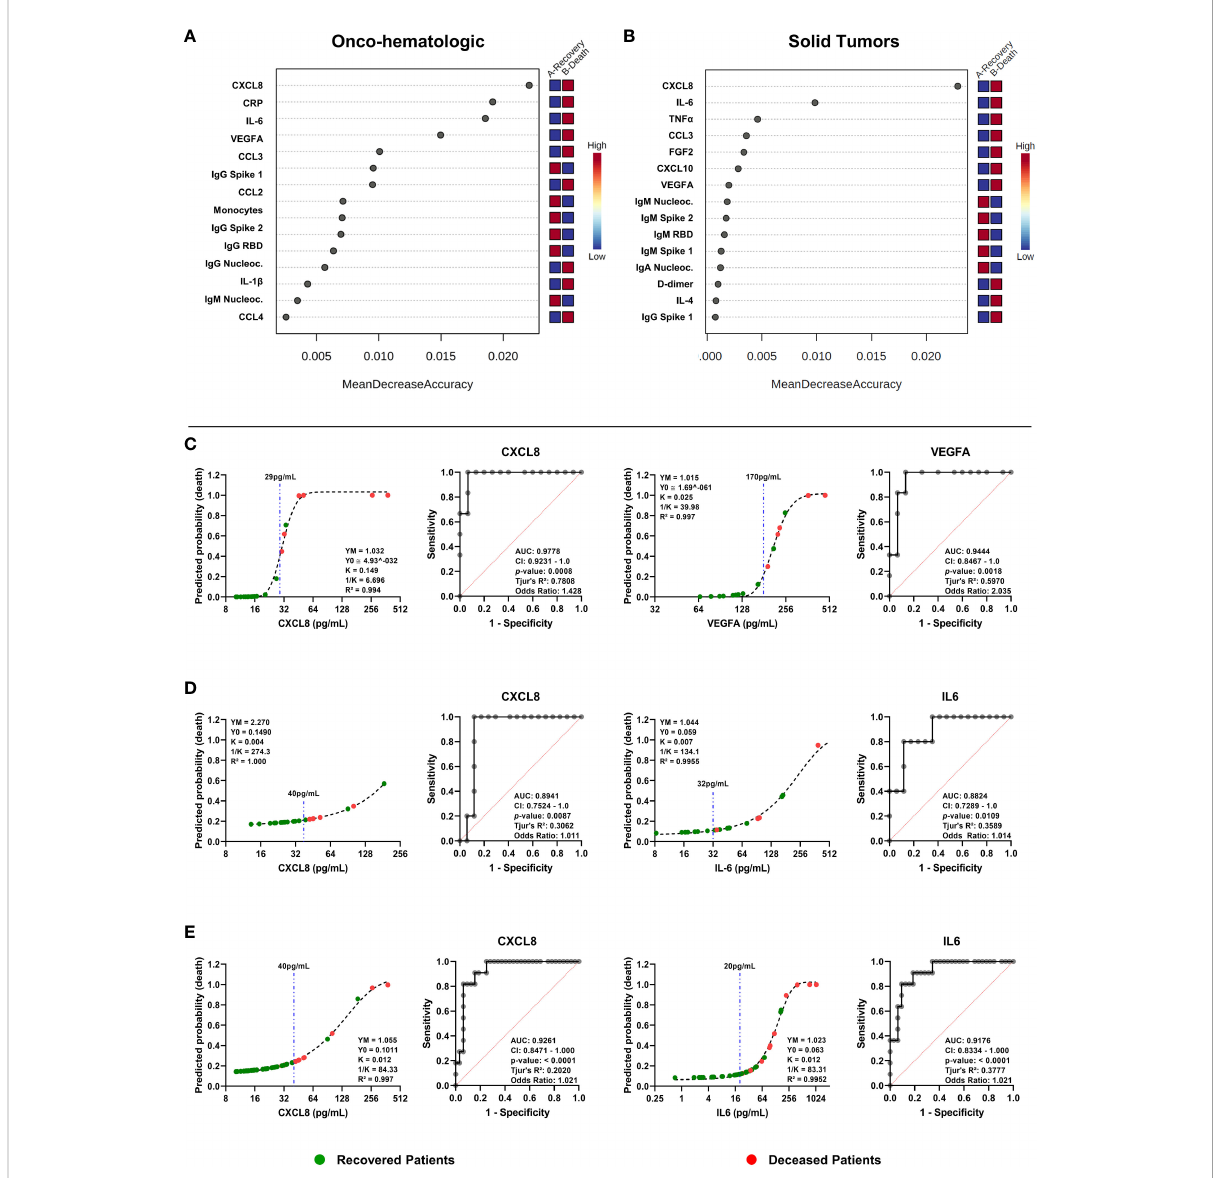
FIGURE 8 Random forests classi fi cation and receiver operating characteristic (ROC) curve analysis indicates CXCL8 as a predictor of death for oncologic patients infected by SARS-CoV-2. Data from electronic health records, 27-Plex assay and anti-SARS-CoV-2 proteins ’ antibodies assays was used as a base for random forests classi fi cation analysis (A, B) or ROC curves construction (C – E) . Graphs in (A) and (B) show the importance of each factor to segregate outcomes of hematologic cancer patients (A, C) or solid tumors patients (B, D) . ROC curves show area under the curve (AUC), 95% con fi dence interval of the AUC, p -value, Tjur ’ s pseudo R² and odds ratio for hematologic cancer patients (C) , solid tumors patients (D) , or both (E) . Related line charts show predicted probability of death, R², and variables for the Gompertz Growth model. Dashed blue lines indicate proposed cutoffs in pg/mL. For both groups the outcomes were de fi ned as recovery (indicating all patients that survived) versus death (all patients that went on to die). In (A, C) , n = 15 for “ Recovery ” and n = 6 for “ Death ” ; In (B, D) , n = 17 for “ Recovery ” and n = 5 for “ Death ” . In (E) , n = 22 for “ Recovery ” and n = 11 for “ Death ” . Nucleocapsid, RBD, Spike 1 and Spike 2 labels refers to antibodies anti-SARS-CoV-2 proteins. CRP, C-Reactive Protein; RBD, Receptor Binding